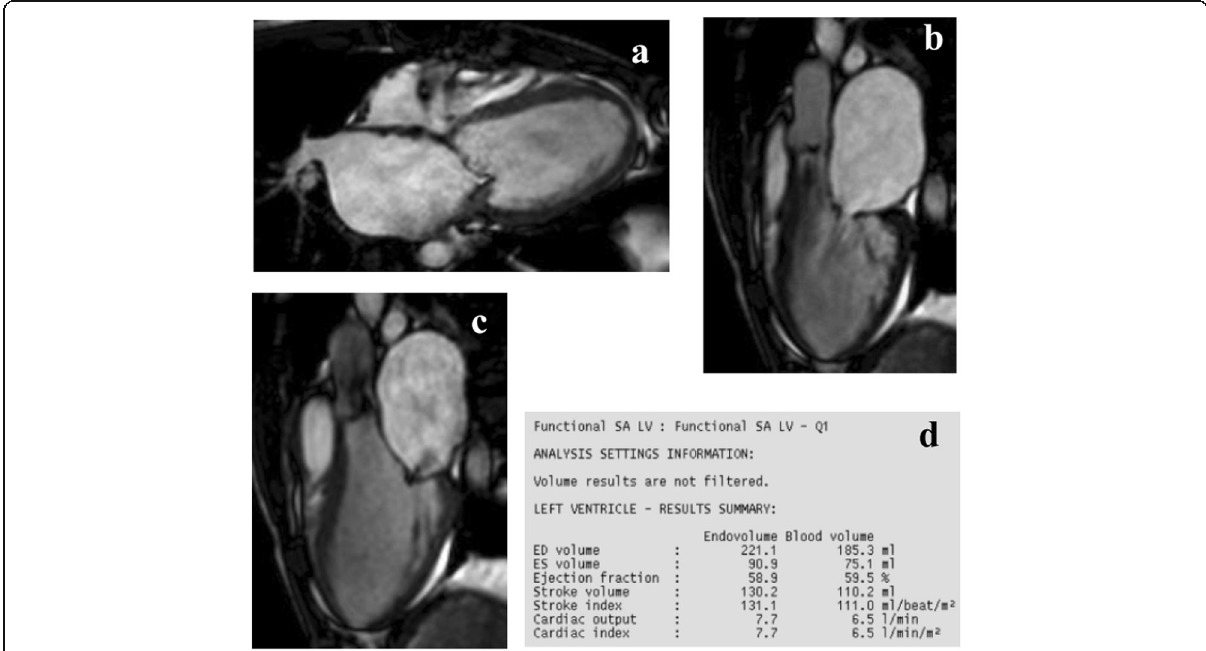
Fig. 6 A 26-year-old male patient with rheumatic valvular heart disease presented by dyspnea grade III. The performed CMR showed mitral and aortic regurge. a Aortic regurge is seen in a three-chamber view during diastole. b , c Mitral regurge is seen in three and four-chamber views during systole. d The volumetric analysis shows that ejection fraction estimated by volumetric short-axis method (EFvol) was 59%